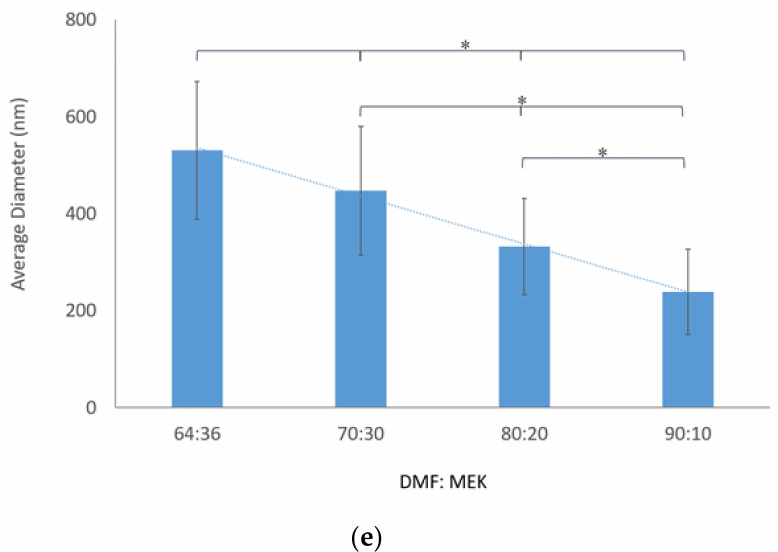
Figure 3. SEM images of PUSX Si01-20 nanofibers under different solvent ratios. ( a ) 64:36, ( b ) 70:30, ( c ) 80:20, and ( d ) 90:10 of DMF:MEK. (Magnification: 2000) ( e ) Average diameters of PUSX Si01-20 nanofibers with different ratios of DMF:MEK. “*” was statistically significant ( p < 0.05) between each two